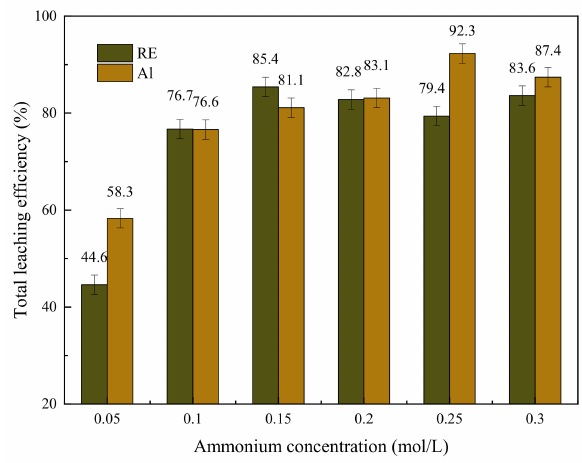
Figure 7. The leaching e ffi ciency of RE and Al under di ff erent compound ammonium carboxylate